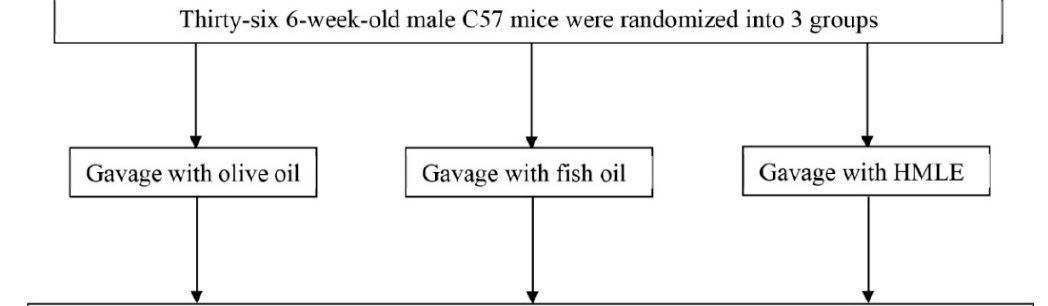
Figure 3. Histological evaluation for the villus height and crypt depth (100×).